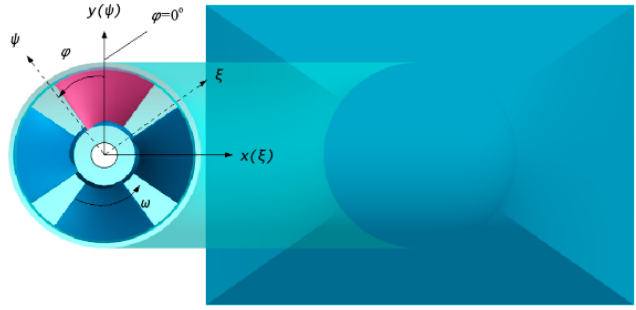
Figure 7. Definition of coordinate systems.